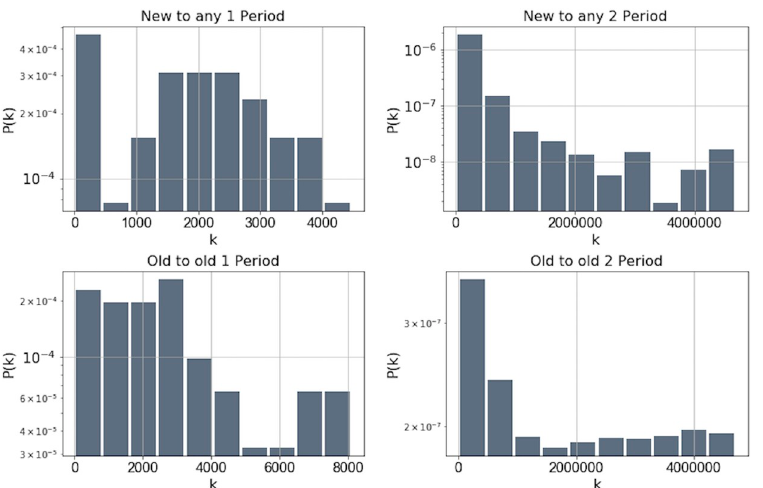
Fig 10. Normalized degree attachment probabilities to new and old (existing) nodes in both periods. We can see that for both new and old nodes, there is no clear preference to attach to the nodes with higher degree.